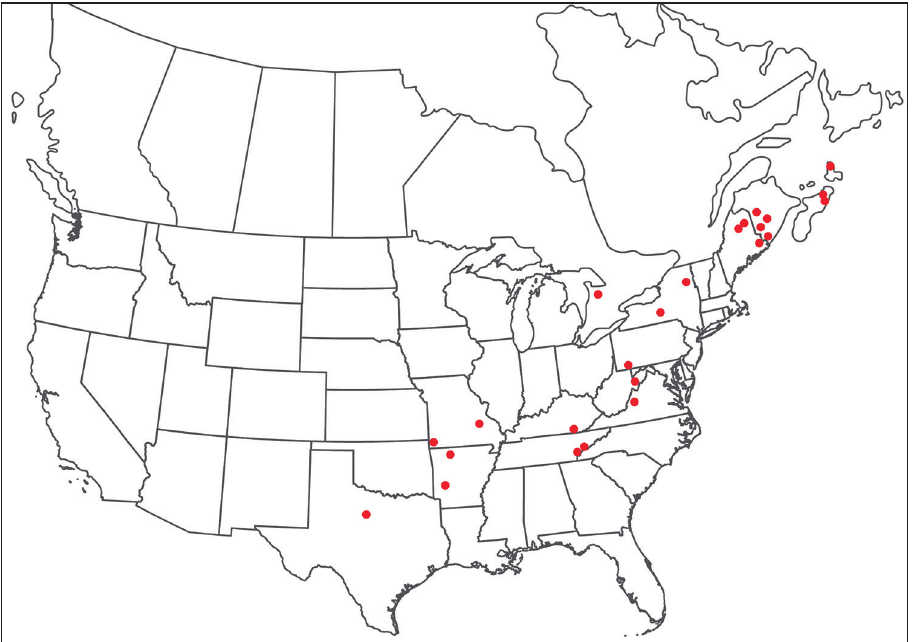
Figure 161. Torrenticola neoanomala